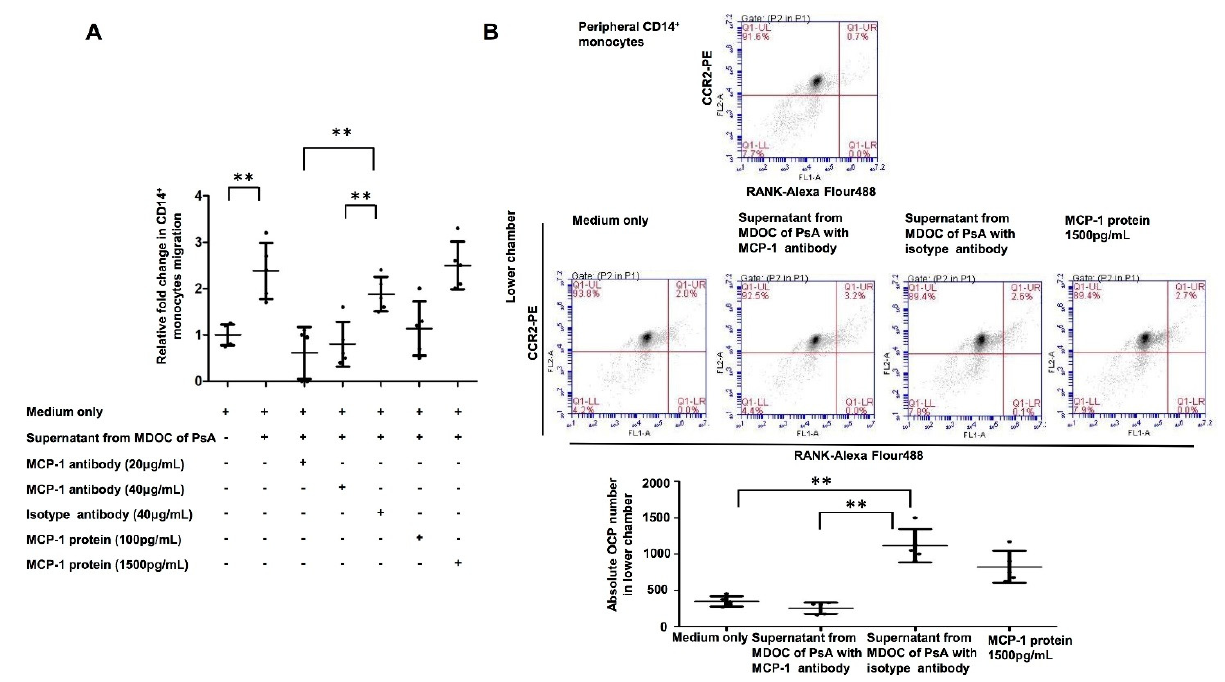
Figure 5. High recruitment of OCP induced by MCP-1 in culture supernatant of MDOC from PsA patients. The supernatants from MDOC of PsA patients ( n = 5) were collected on Day 13 for Transwell chemotaxis assays. ( A ) Supernatants were mixed with MCP-1 antibody at 20 or 40 ng/mL or corresponding isotype antibody at 40 ng/mL for the lower chamber. In other sets, culture medium supplemented with recombinant MCP-1 protein at 100 and 1500 pg/mL was placed in the lower chamber. The CD14 + monocytes from HC ( n = 5) were placed above the filter (upper chamber) to allow chemotaxis for 1 h. We measured the migration of CD14 + monocytes to the lower chamber using a Cell Counting Kit-8. ( B ) The numbers of CD14 + monocytes in the lower chamber were determined. OCP, defined as CCR2 + RANK + expressing CD14 + monocytes, were identified by multicolor flow cytometry. The absolute numbers of OCP in the lower chambers were calculated based on the multiplication of the percentage of CCR2 + RANK + in the Q1 quadrant and the total numbers of cells that migrated into the lower chamber. The secondary antibodies were conjugated with different fluorescent markers (RANK: Alexa Flour488 and CCR2: PE). The isotypes of individual antibodies were used as negative controls. The medium only, supernatant from MDOC of PsA with MCP-1 antibody, supernatant from MDOC of PsA with isotype antibody, or MCP-1 recombinant protein (1500 pg/mL) was added into the lower chamber ( n = 5 each). The percentages of CCR2 + RANK + expressing CD14 + monocytes in the upper and lower chambers were measured. The error bar represents the standard deviation of each data set. ** p indicates <